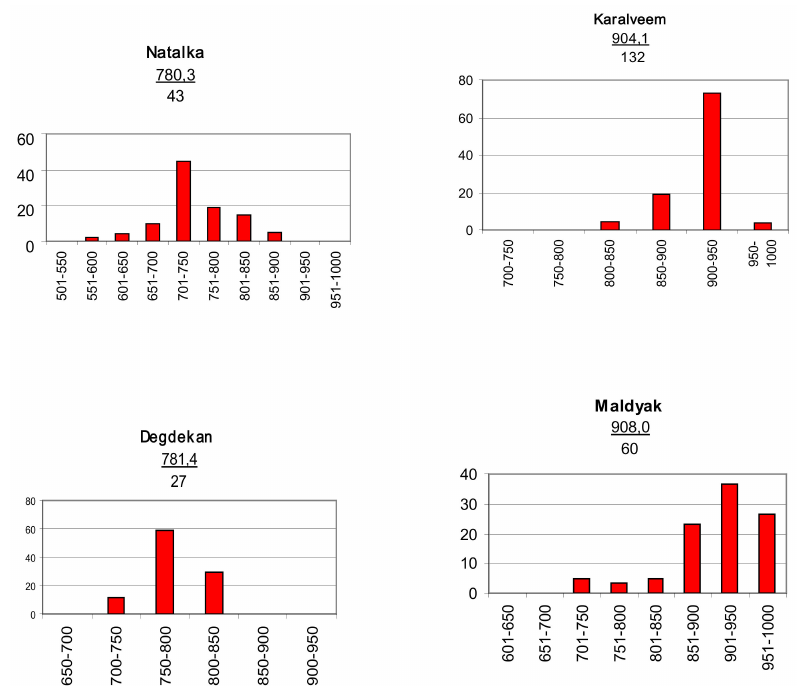
Figure 2. Histograms showing fineness of native gold for deposits of gold–arsenic-sulfide GIT on the abscissa axis—frequency of occurrence, %; along the x -axis, fineness intervals, ‰; in the numerator—fineness, ‰, in the denominator—the number of determinations.